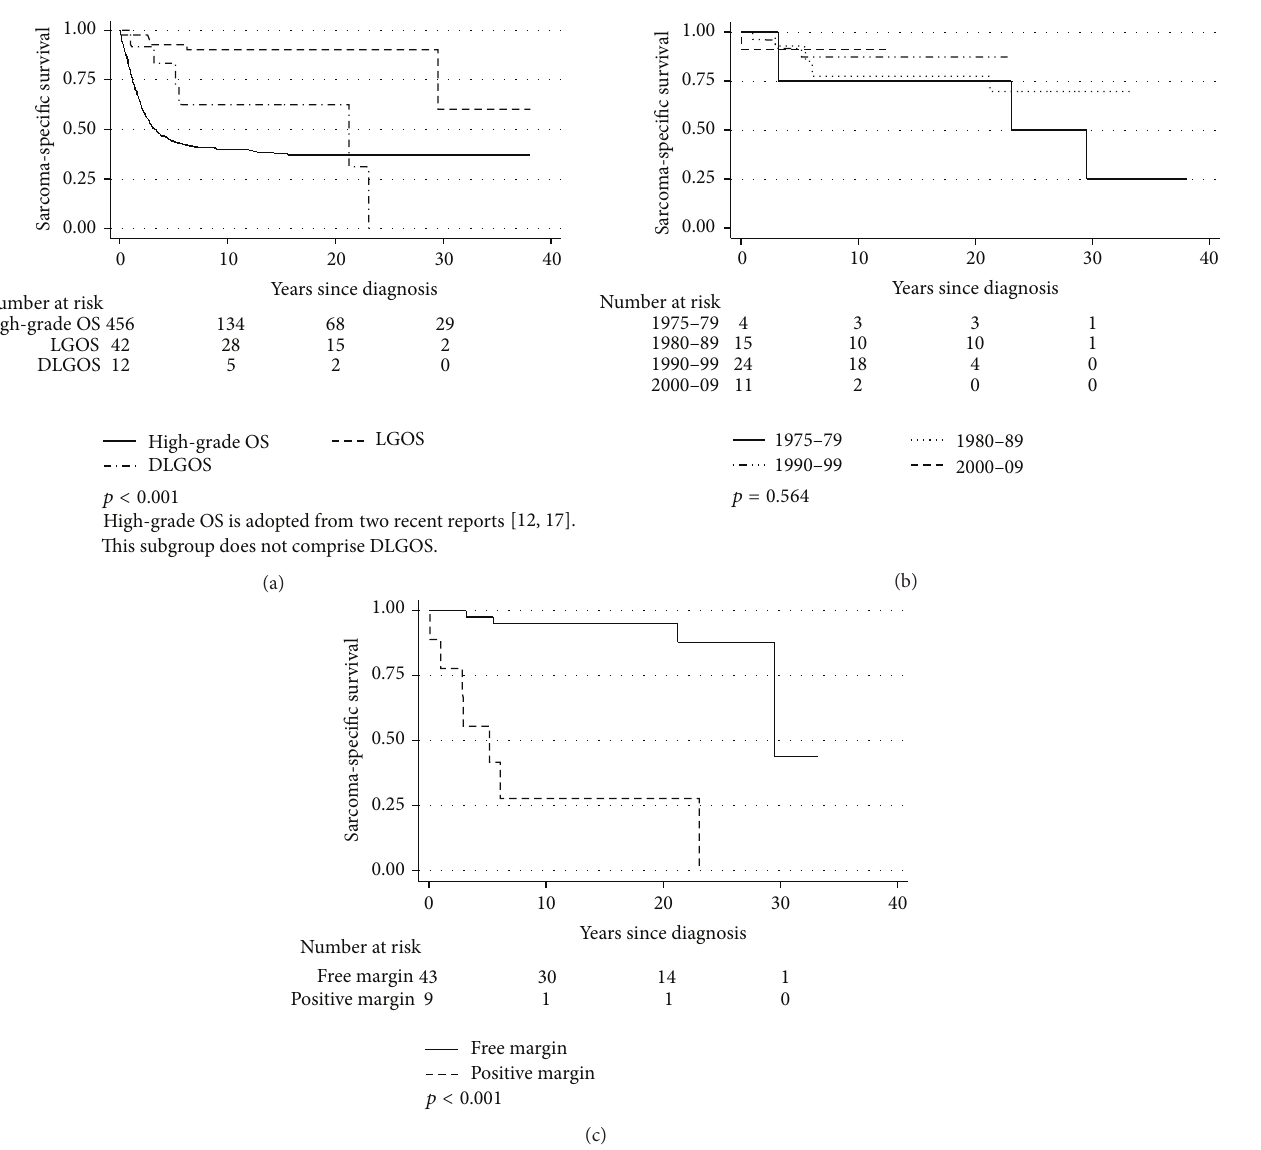
Figure 2: Sarcoma-specific survival of low-grade (LGOS) and dedifferentiated osteosarcoma (DLGOS) versus (a) high-grade OS, (b) dependent on time of diagnosis, 1975–2009, and (c) by best local surgical